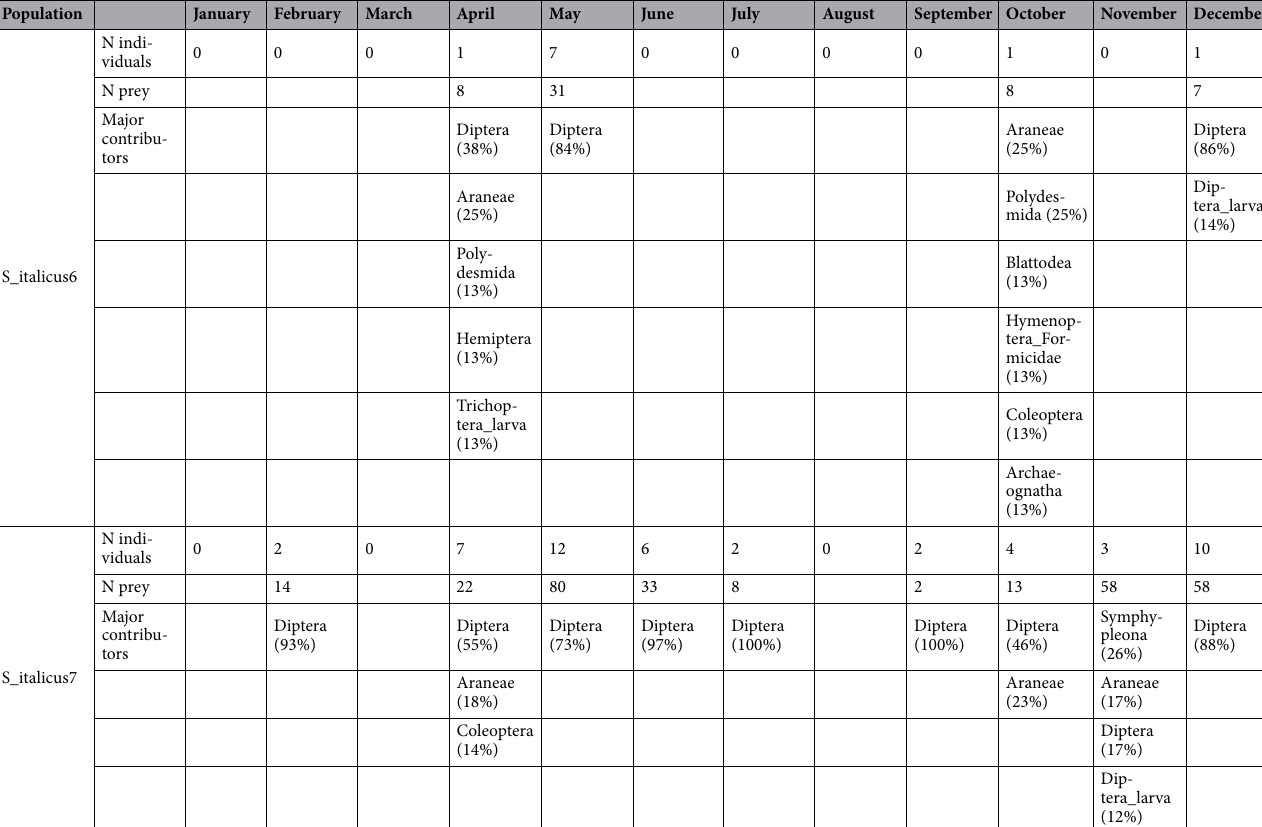
Table 2. Summary of the monthly prey consumed by individuals from the six subterranean populations of Speleomantes italicus . The table shows the following monthly data for each populations: number of individuals